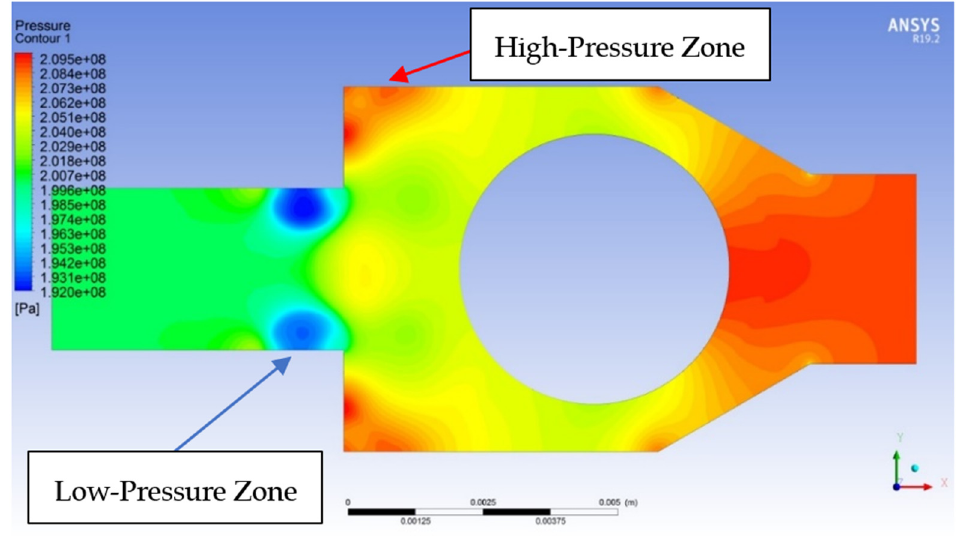
Figure 11. Pressure CFD: Conical Seat Valve − x = 1.257 [mm], pdn = 2000 [bar] and pup = 2100 [bar].